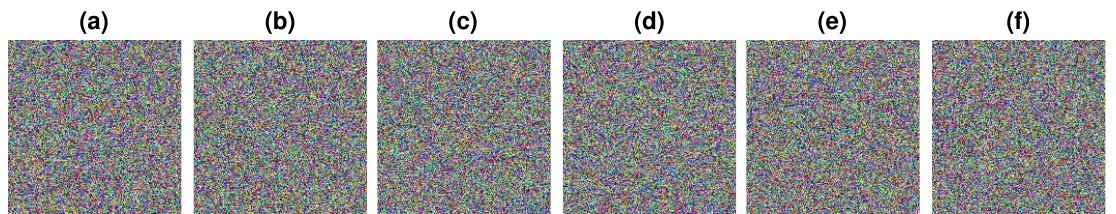
Figure 2. Original images on which the proposed algorithm was tested: ( a ) Jet, ( b ) Home, ( c ) Barbara,